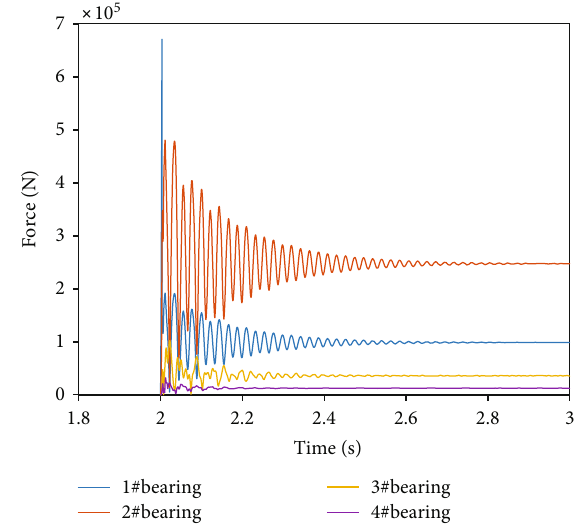
Figure 14: Reaction force of a rotor system with varied-sti ff ness fusing structure.